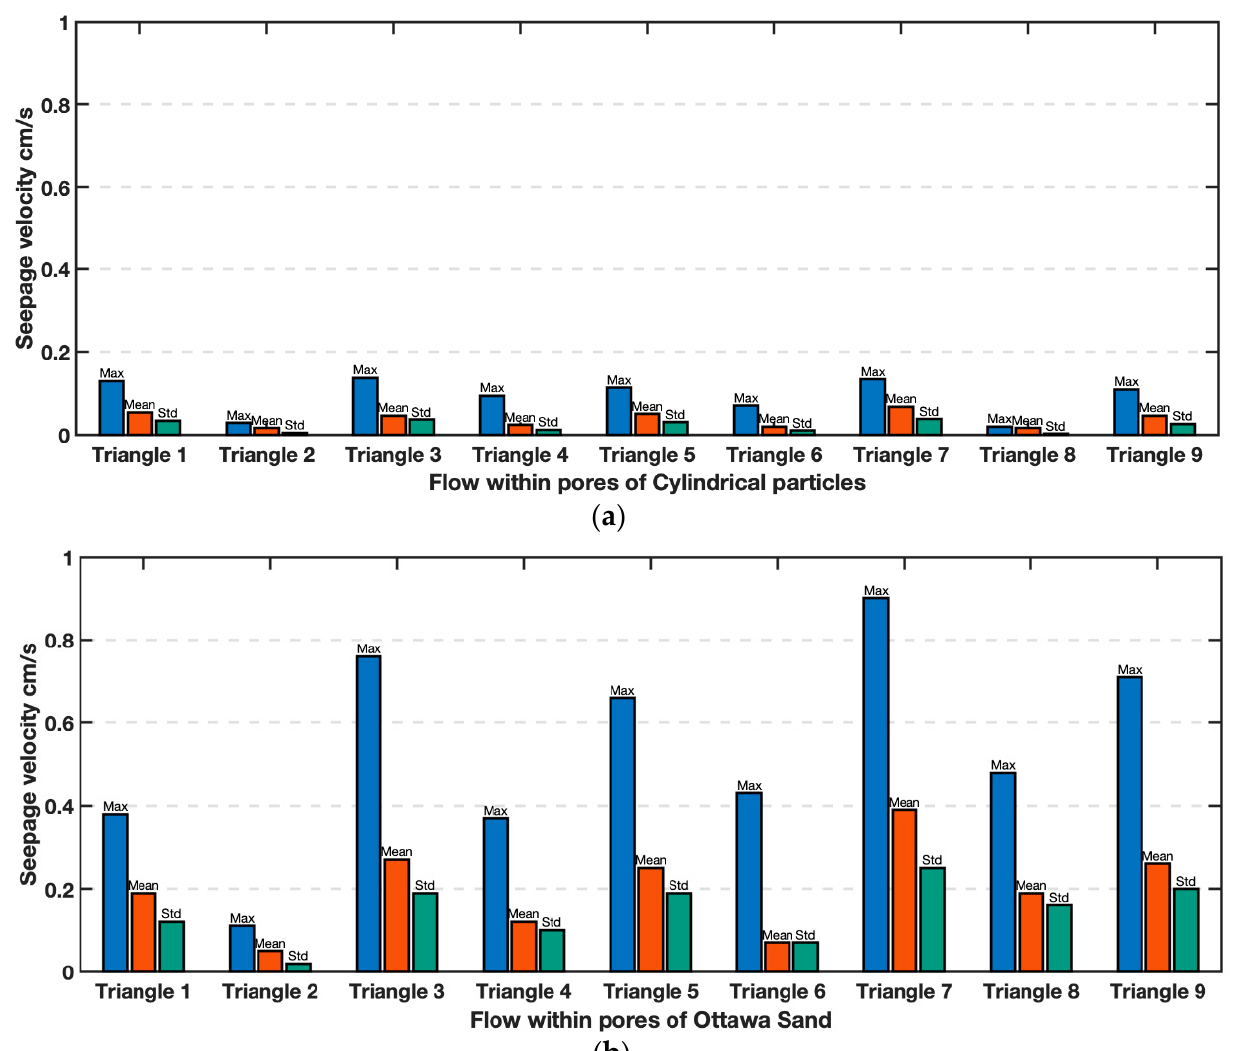
Figure 13. Distribution of flow velocities in between ( a ) Cylindrical particles ( T = 2 s) and ( b ) simulated Ottawa sand particles ( T = 0.248 s).